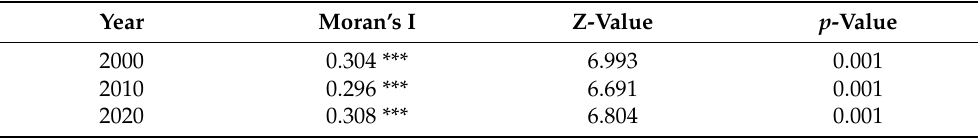
Table 5. Univariate Global Moran’s I index of CLF in Guangdong Province on the county scale in